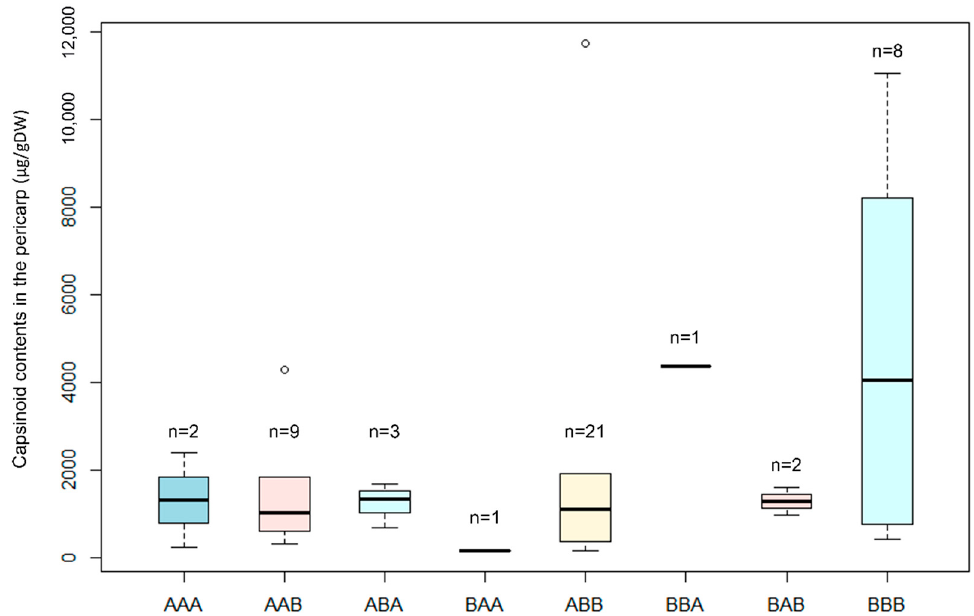
Figure 4. Pericarp capsinoid contents of the nine genotypes across three ‘SJ’ QTLs. The order of the three markers is SJ_TCP4.1_hrm, SJ_TCP6.2_hrm, and SJ_TCP_6.1_caps, with A and B indicating the ‘SNU11–001’ and ‘Jolokia’ alleles, respectively. The number of pamt mutant F 2 plants identified for each genotype is indicated above each column. Empty circles indicate outlier values.